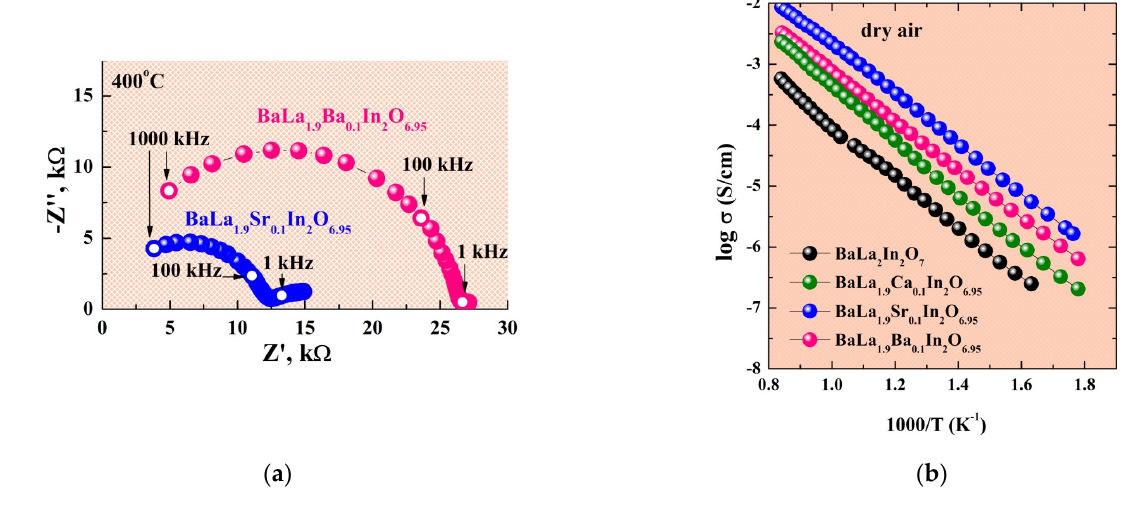
Figure 4. The EIS plots obtained at 400 °C for the compositions BaLa 1.9 Sr 0.1 In 2 O 6.95 and BaLa 1.9 Ba 0.1 In 2 O 6.95 ( a ) and temperature dependencies of conductivity for investigated compositions obtained under dry air ( b ).